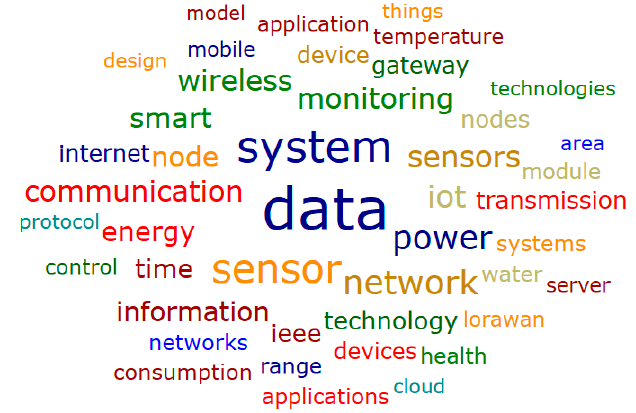
Figure 20. Rate of research works related to smart cities in the last three years.